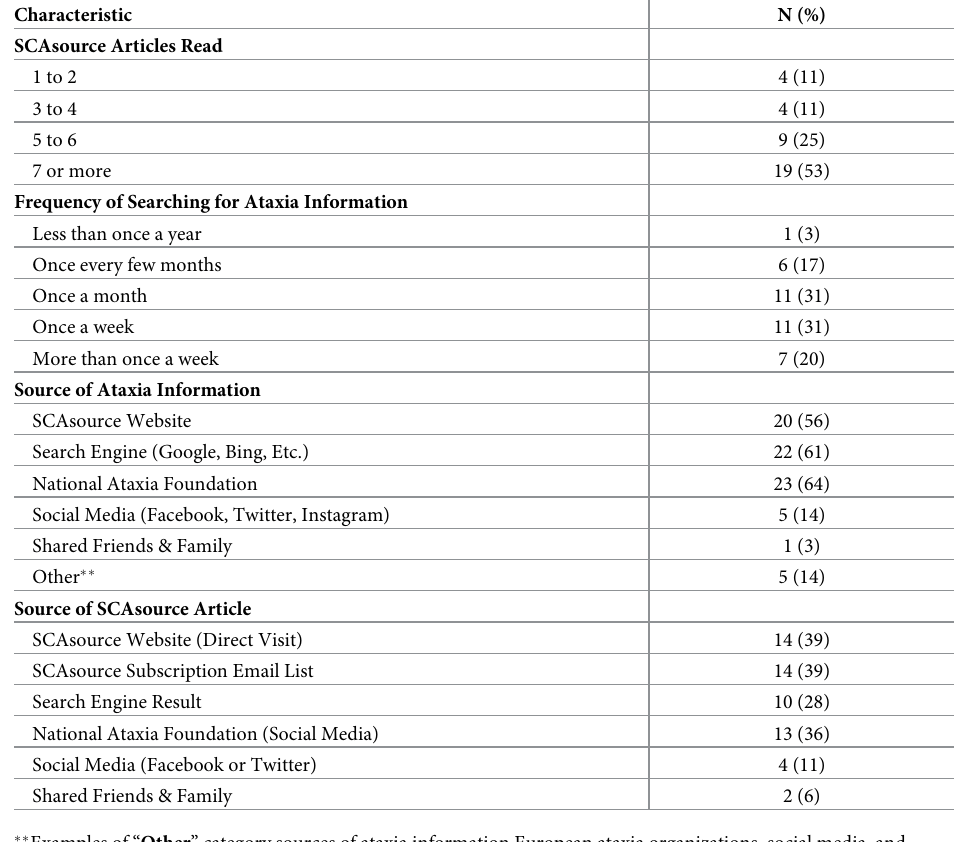
Table 2. Reader respondent